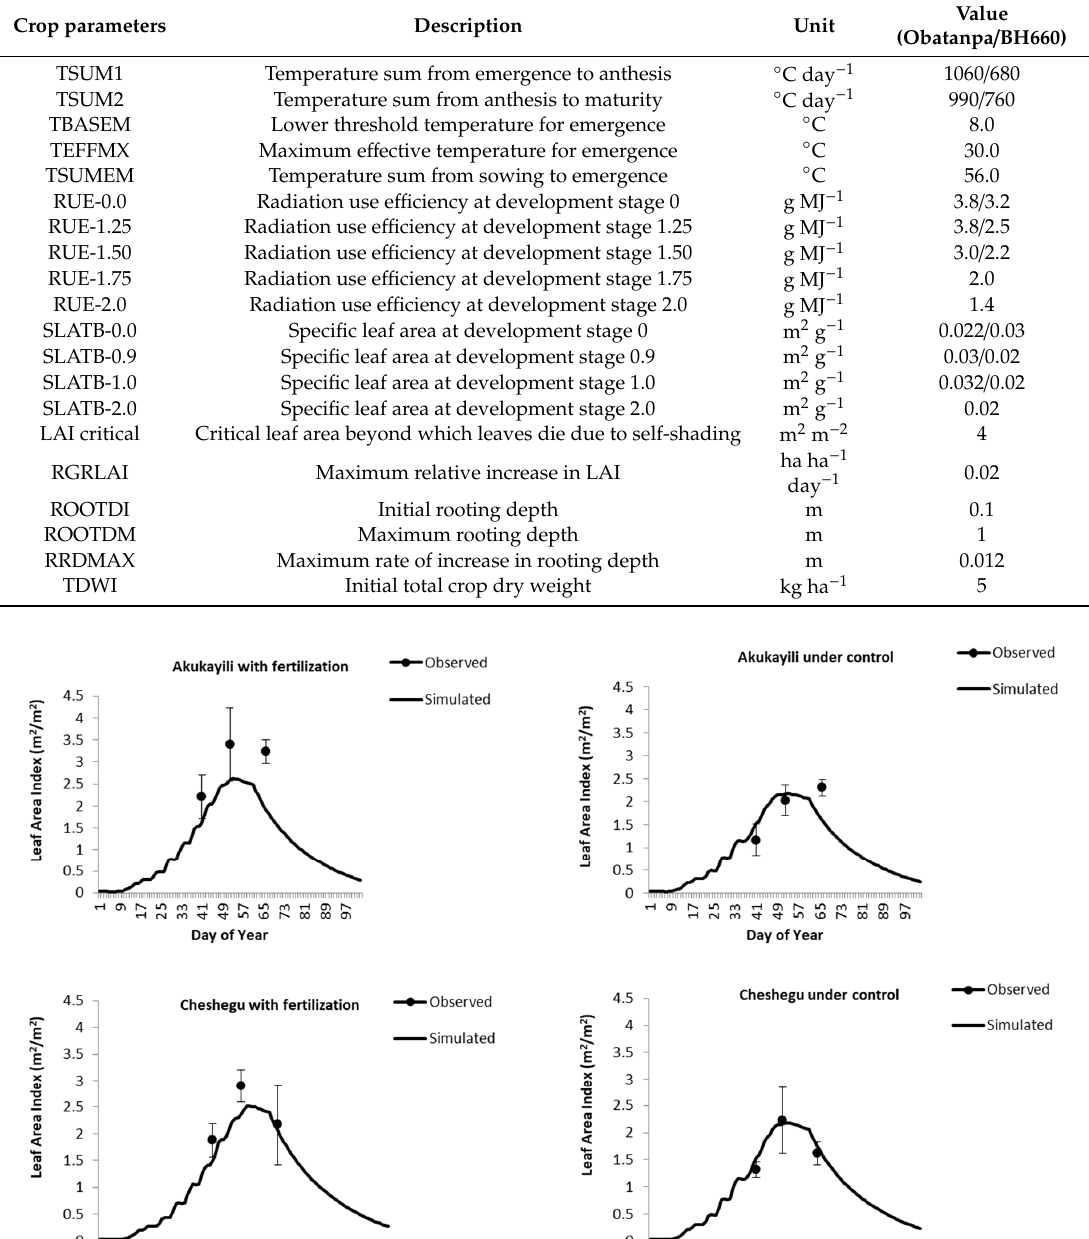
Table 2. Crop parameters of LINTUL5 used in the study for maize variety ‘Obatanpa’ and ‘BH660’. Crop parameters